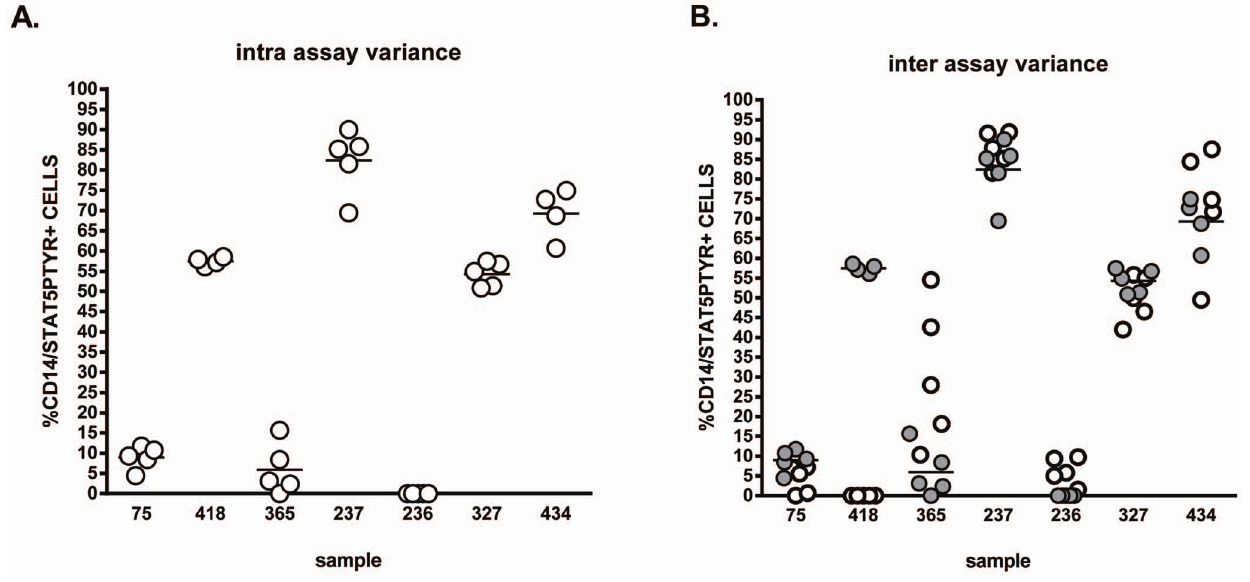
Figure 2. Intra- & Inter-assay Variance for the flow cytometric analysis of STAT5Ptyr in human peripheral blood monocytes. Whole blood from T1D ( # 418, 237,327, and 434) and non-autoimmune healthy controls (75, 365, and 236) was analyzed for STAT5 activation as described in the Methods & Materials. Each sample aliquot was analyzed 4 to 5 times during each run of the analyses. A. Intra-assay Variance : There was an assay variance of , 5% in between control samples and intra-assay from 0 to 6.3% for a given control sample’s analysis; whereas, there was an assay variance of , 13% between T1D samples with an intra-assay 1 to 7.9% for a given T1D sample’s analysis. There was a significant ( . 13-fold) difference between the % STAT5Ptyr/CD14 + cells detected in the T1D samples tested (mean 65.85%, SD 12.79%, n=4) as compared to controls analyzed in the same assays (mean 4.952%, SD 4.547%, n=3). B. Inter-assay Variance: Each sample analyzed 24 hr to 48 hr after shipment and storage at 4 u C. An inter-assay variance of 2-6-fold between 24 hr (filled circles) and 48 hr (clear circles) assay runs of 3 control samples and a 1.1-fold variance in 3 T1D samples was seen between 24 and 48 hrs. At 24 hr, there was a significant ( . 13-fold, *p=0.0017) difference between the % STAT5Ptyr/CD14 + cells of T1D samples (mean 65.85%, SD 12.79%, n=4) as compared to controls (mean 4.952%, SD 4.547%, n=3) in same assays. However, this significant difference decreased to 5.4-fold at 48 hr (*p=0.013), due to the increased inter-assay variability seen in control samples after storage.